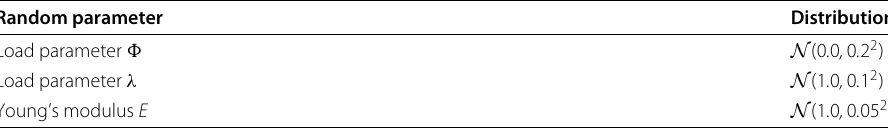
Random parameter Distribution